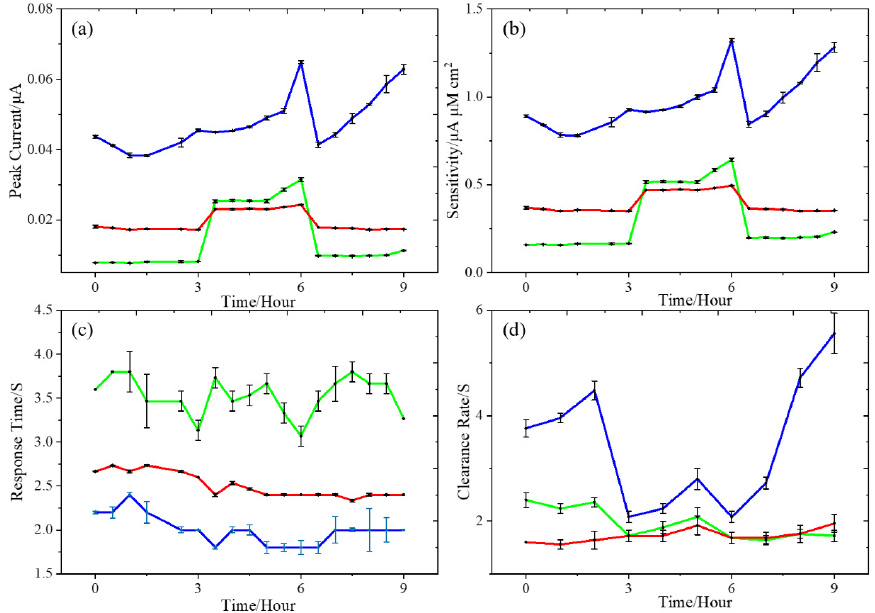
Figure 5. Long-term evaluation of three BDUNCD microelectrode types in terms of ( a ) peak currents, ( b ) sensitivity, ( c ) response time, and ( d ) clearance rates. Experimental conditions: 1 droplet per min with a background flow rate of 0.1 mL/min in 1X PBS) and 0.02 mL (100 μ M, DA) droplet volume. The applied potential was +0.35 V vs. Pt microwire; every 30 min we took five signals and calculated the error bar in the 9-h experiment. The green color represents the unmodified BDUNCD microelectrode, the red color represents the nafion-modified BDUNCD microelectrode, and the blue color represents nafion–MWCNT-modified BDUNCD microelectrode.